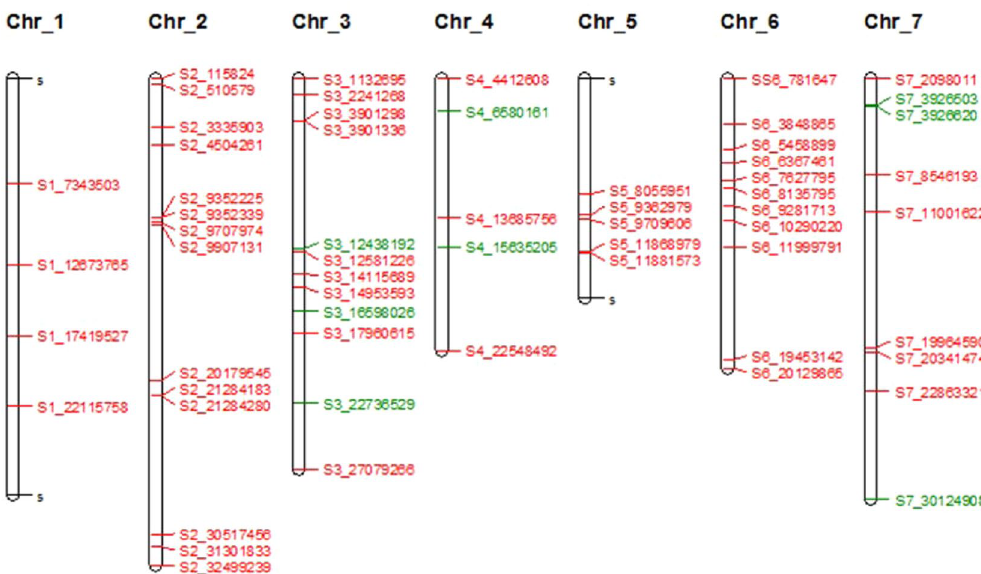
Figure 3. Molecular map showing position of loci potentially under selection as measured by two methods (BayeScan and Sam β ada). The red SNPs are those that have been identified by both methods. The green SNPs are unique to